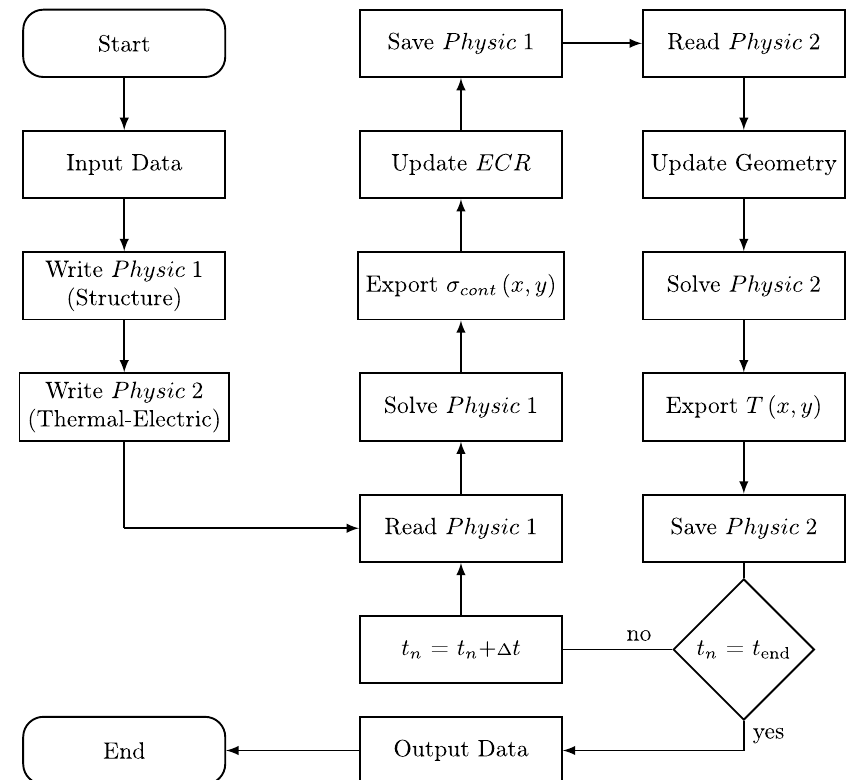
Figure 4. Schematic sequence of an indirect coupled numerical simulation in A NSYS M ECHANICAL APDL.